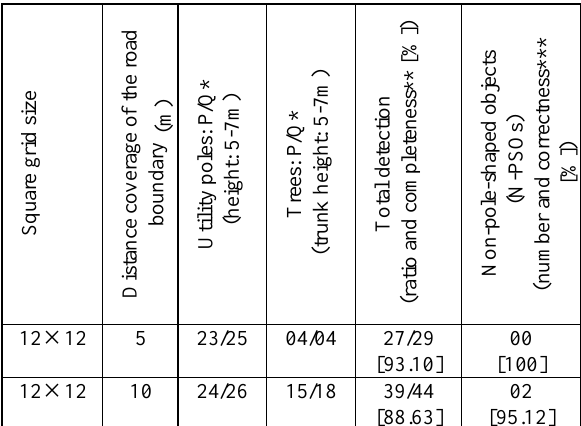
Table 1. Threshold values of parameters used in the proposed